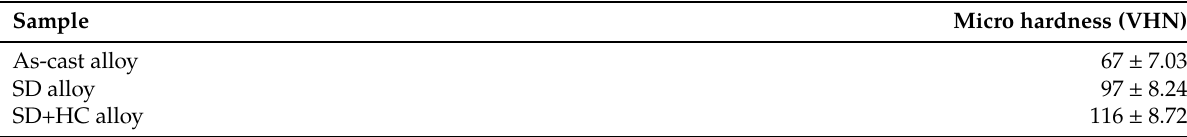
Table 5: Micro hardness of as-cast, SD and SD+HC Al-28Si